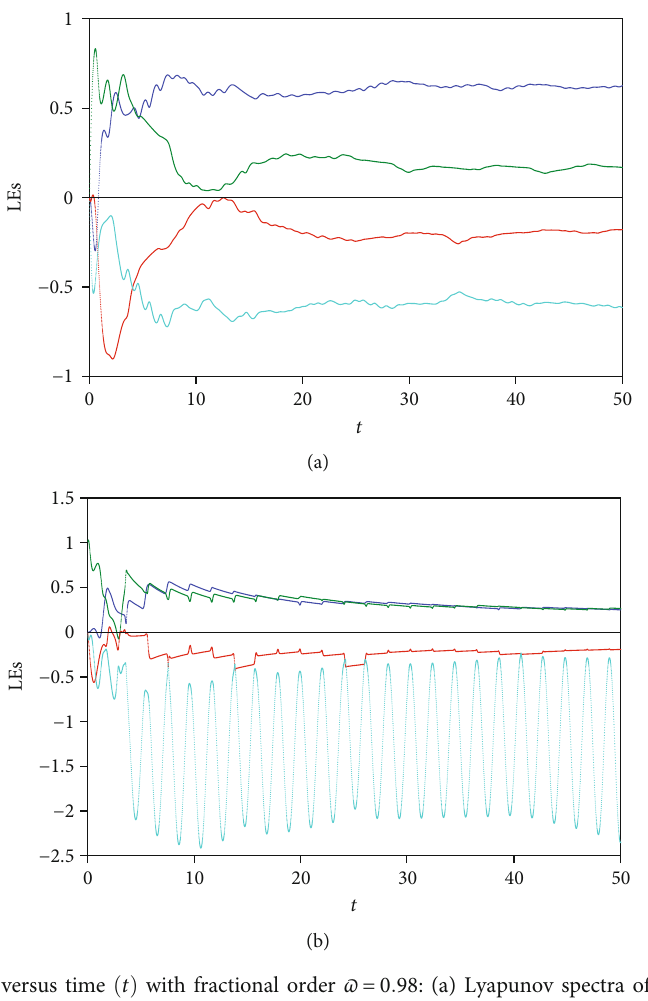
Figure 1: The Lyapunov spectra versus time ð t Þ with fractional order ϖ = 0 : 98 : (a) Lyapunov spectra of system 1 with c = 2, d = 5 , (b) Lyapunov spectra of system 2 with m = 2, n = 5